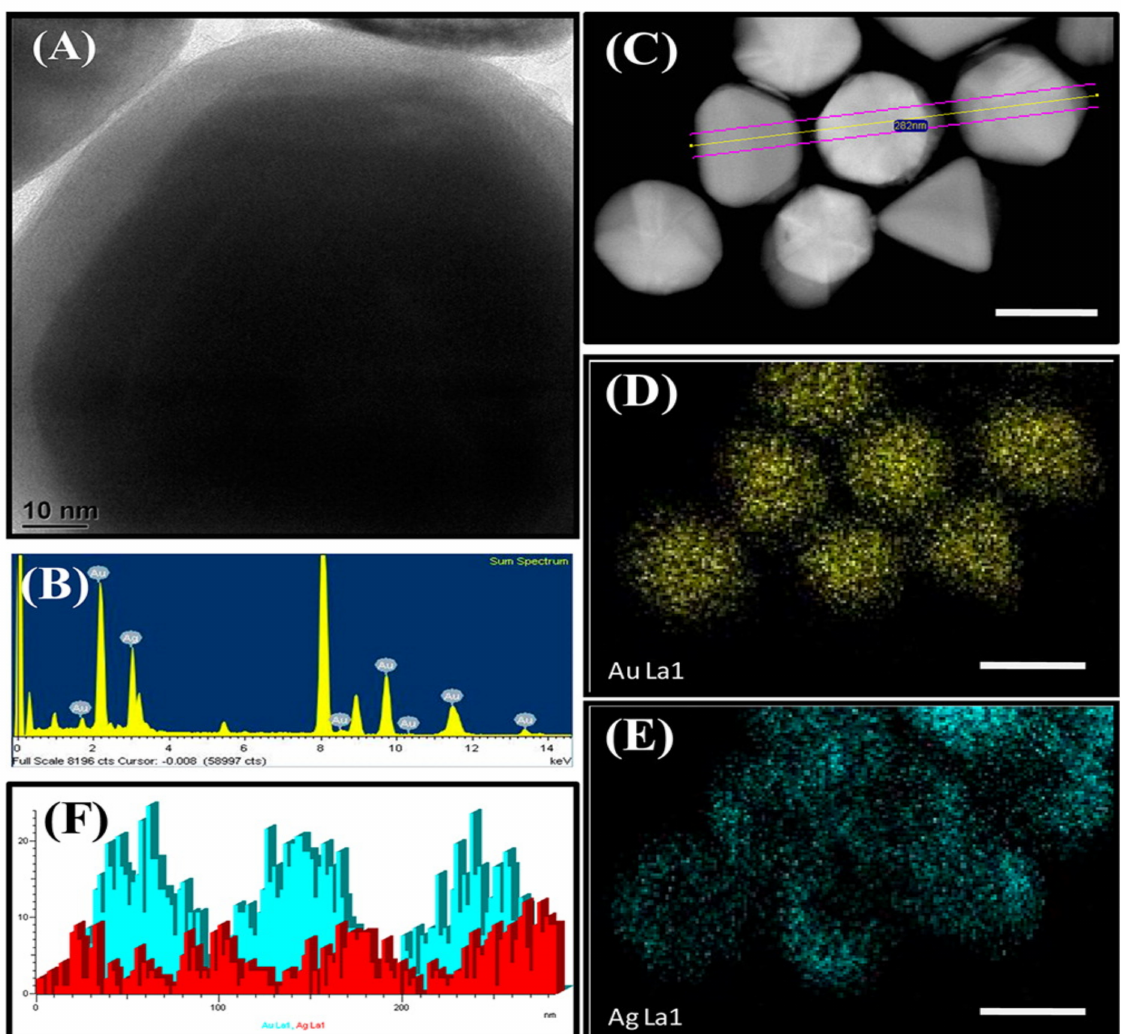
Figure 7. Morphological and elemental characterization of bimetallic (Au–Ag) core–shell nanoparti- cles and their elemental mapping. ( A ) TEM image, ( B ) EDAX spectra, ( C ) STEM–dark field image, ( D , E ) corresponding element mapping images of Au100/Ag bimetallic core–shell NP (scale bar in C–E is 100 nm), and ( F ) EDAX line scan representing Au (cyan) and Ag (red) shown in panel C Reproduced with permission from ref. [92] Figure 3. (ACS Publication ®